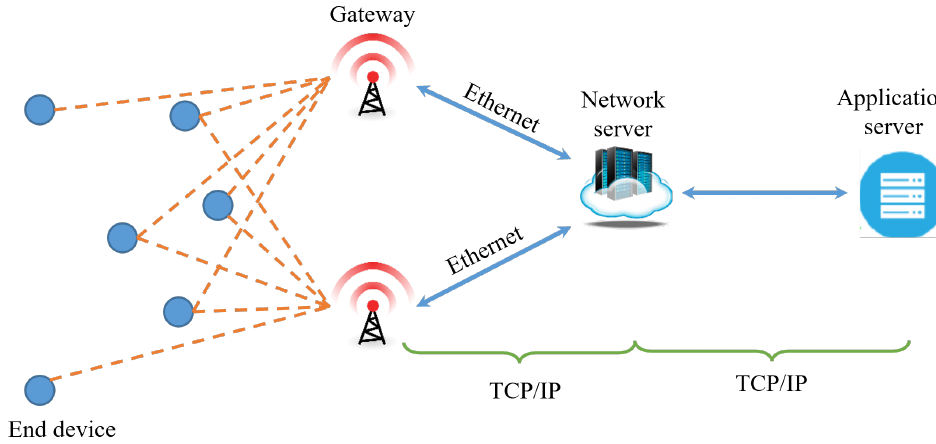
Figure 1. Simple topology for LoRa